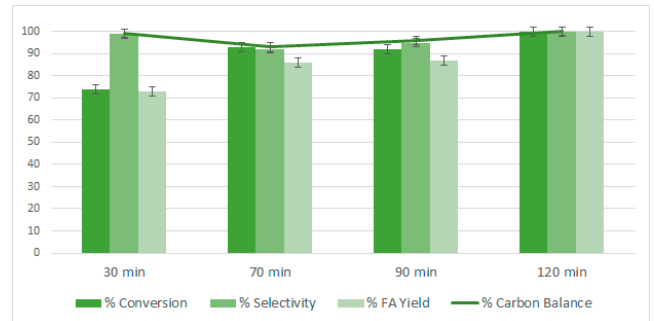
Figure 7. Effect of the reaction time using Au/HT 4:1. Furfural oxidation, batch reactor, p = 6 bar (O 2 ), Figure 7. E ff ect of the reaction time using Au / HT 4:1. Furfural oxidation, batch reactor, p = 6 bar (O 2 ), t = 110 °C, 600 rpm, FF/Au = 80:1, [FF] = 26 mM, 63 mg of catalyst. t = 110 ◦ C, 600 rpm, FF / Au = 80:1, [FF] = 26 mM, 63 mg of catalyst.